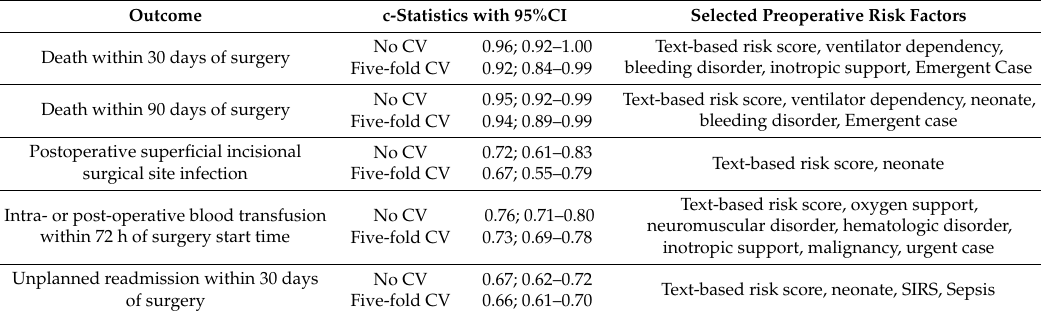
Table 3. Logistic regression of outcome including text-based risk score as a